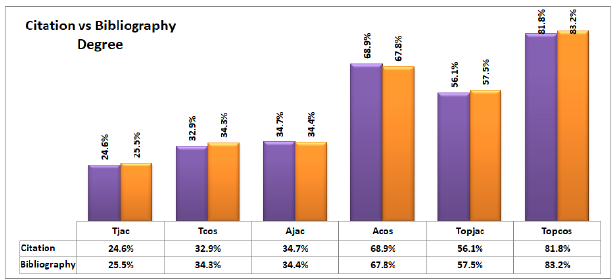
Figure 5. Comparison Between Citation and Bibliography Through